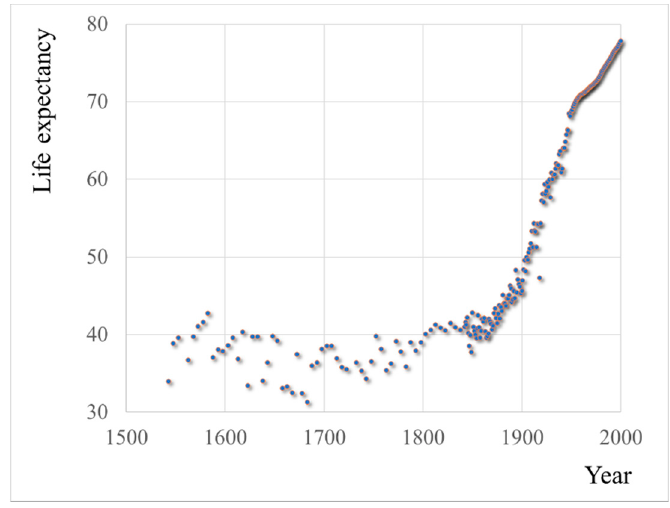
Figure 11. United Kingdom’s life expectancy, data from: 1800–2016 [66,67].